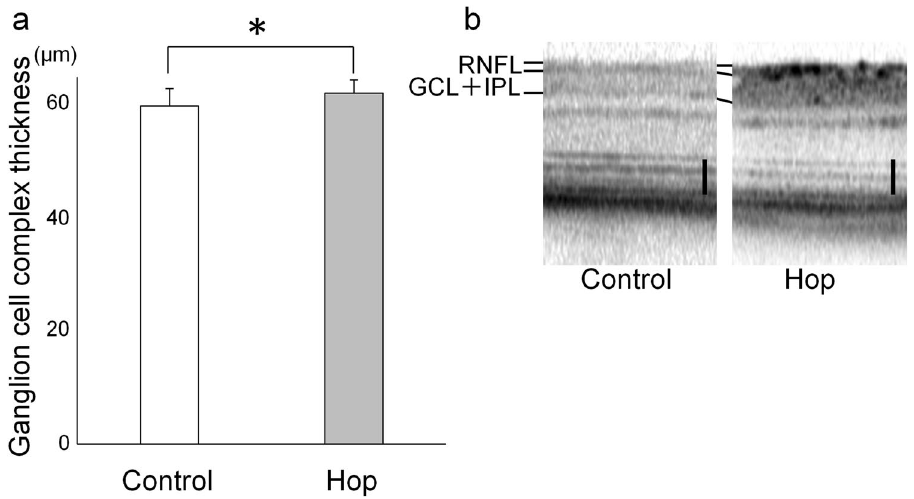
Figure 1. Prevention of ganglion cell complex thinning in GLAST (−/−) mice. ( a ) Ganglion cell complex thickness in 12-week-old GLAST (−/−) mice administered with hop extracts or water as a control.